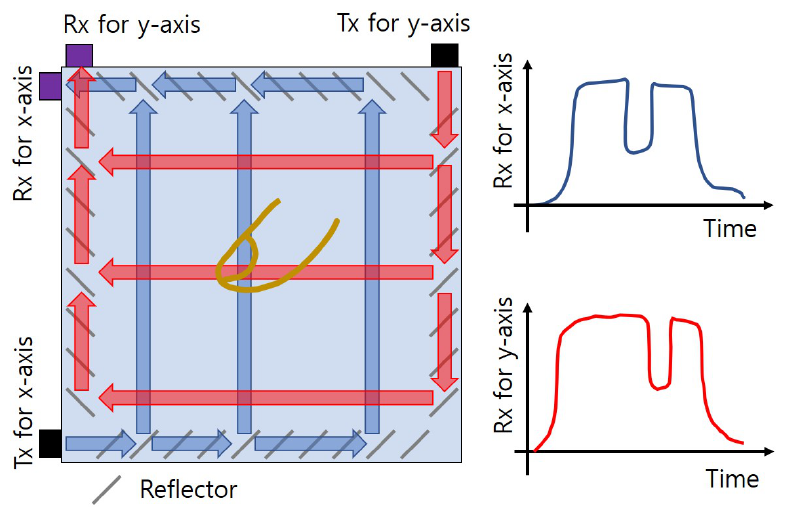
Figure 5. Surface acoustic wave (SAW) touchscreen. The ultrasonic waves move through multiple horizontal and vertical paths. The finger touch attenuates the received signal strength in the contacted wave paths and their delay information is converted to the touch